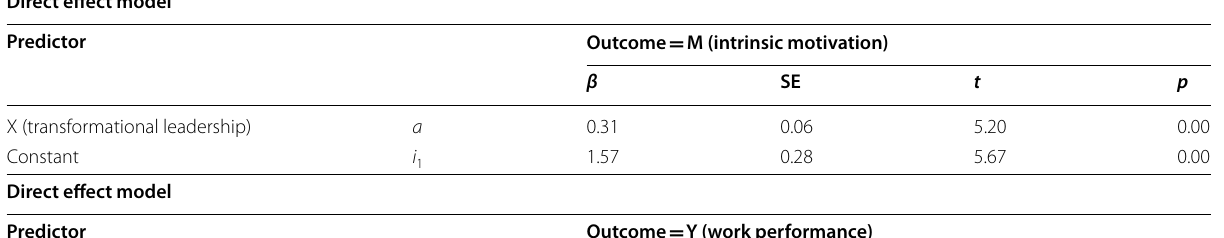
Table 4 Results of simple mediation model for work performance